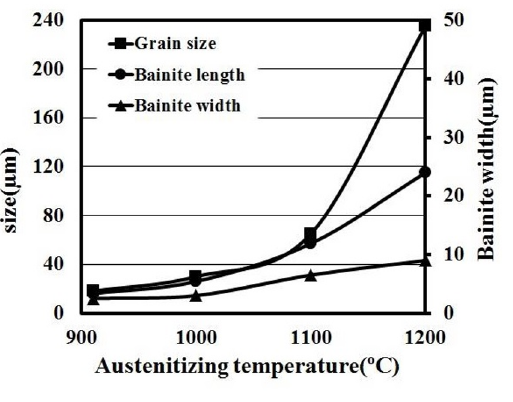
Figure 3. Variation of microstructural factors as a function of austenitizing temperature.